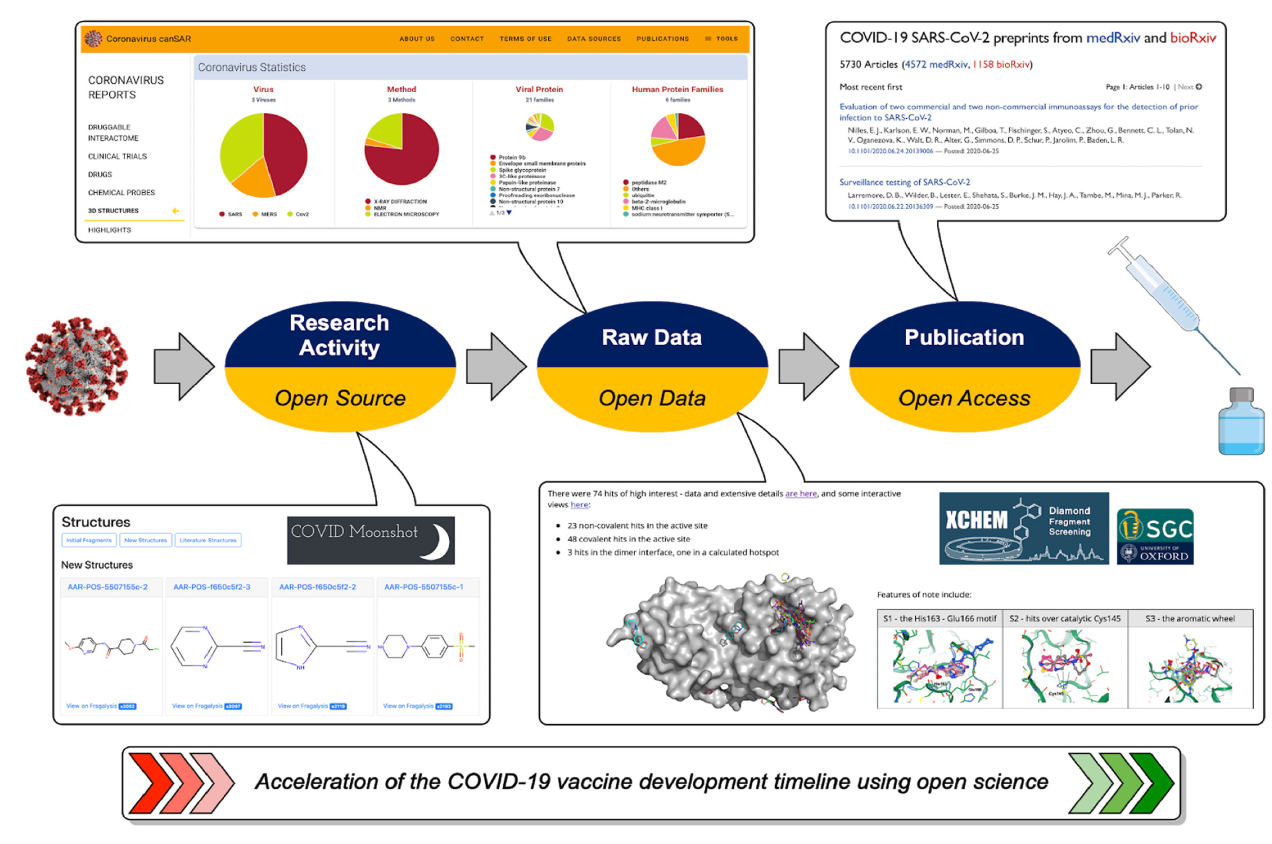
Figure 1. Application of open science for COVID-19 vaccine/treatment development. Representative examples from the development timeline include the COVID Moonshot project, the ICR canSAR tool, the Diamond XChem fragment screen and preprint